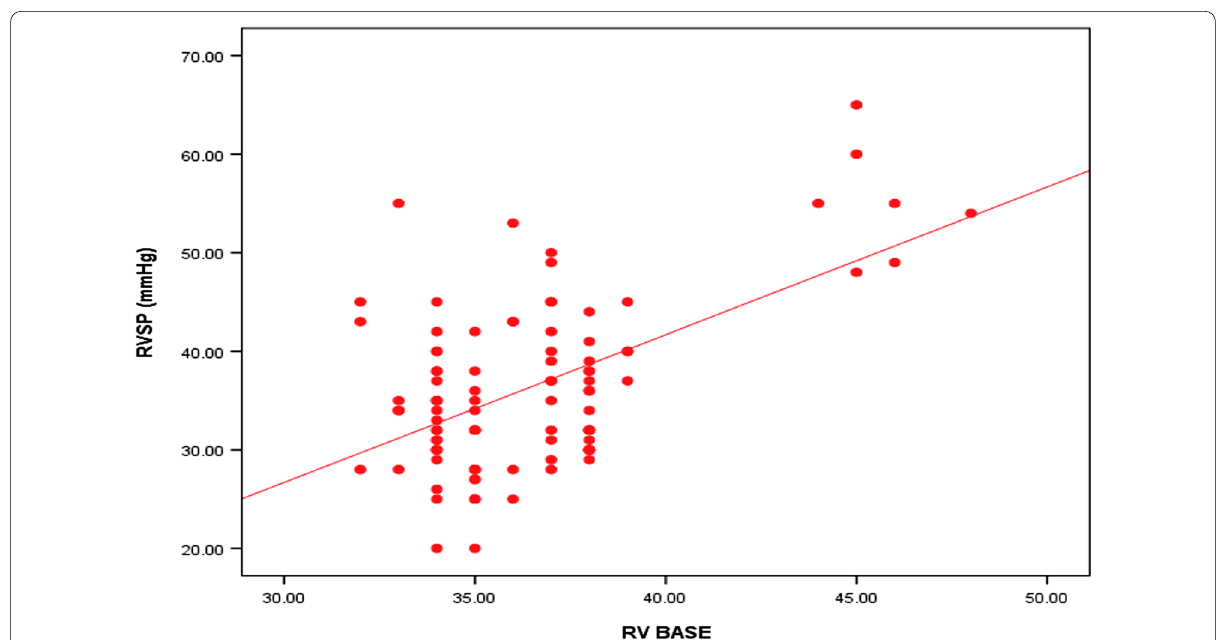
Fig. 1 Spearman correlation between RVSP and RV base